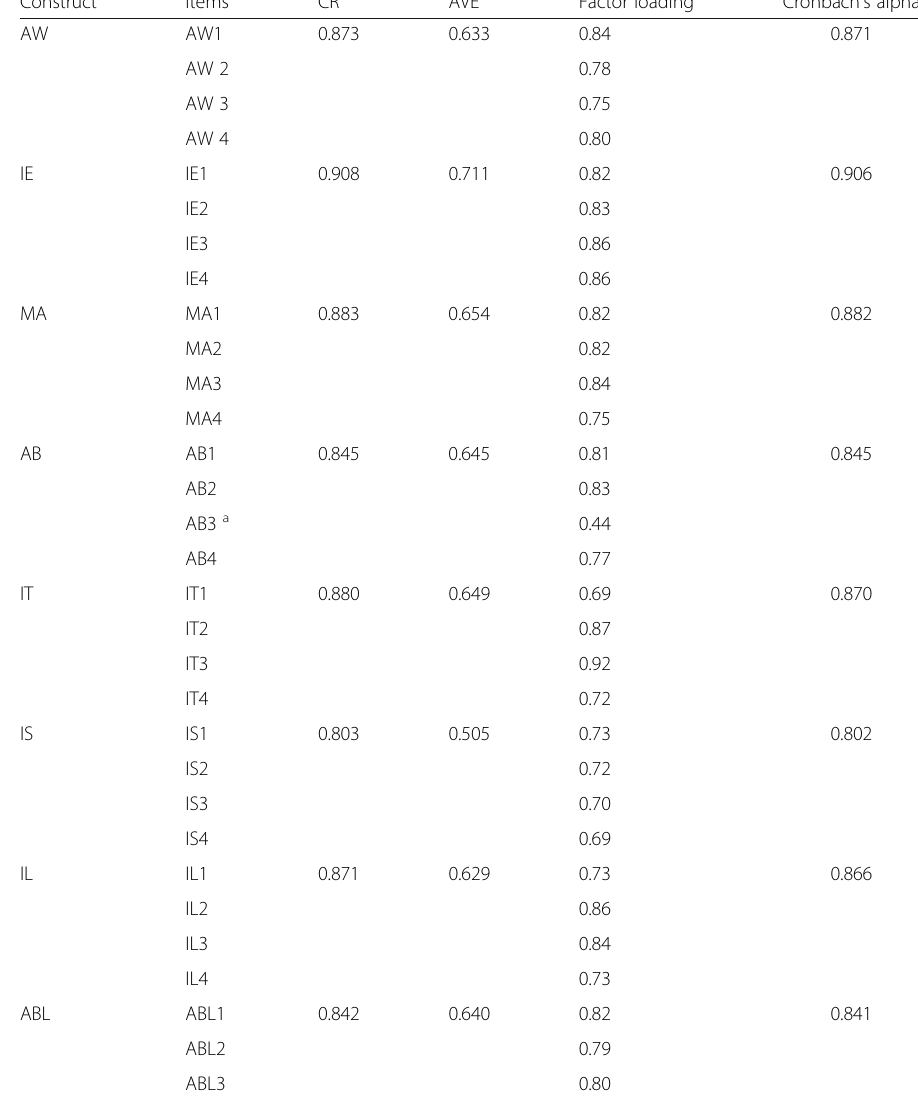
Table 3 Result for Reliability and Constructs validity test Construct Items CR AVE Factor